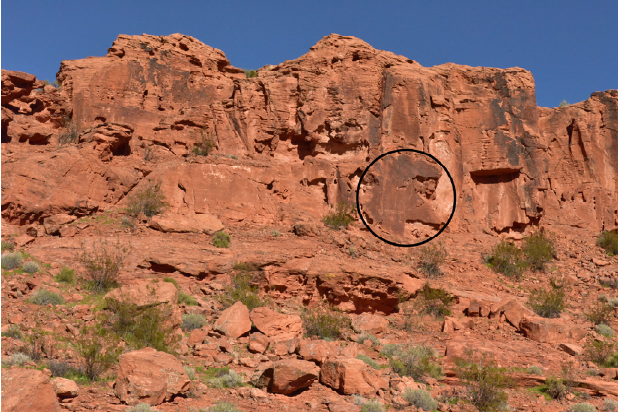
Figure 9. St. George WMP site location.